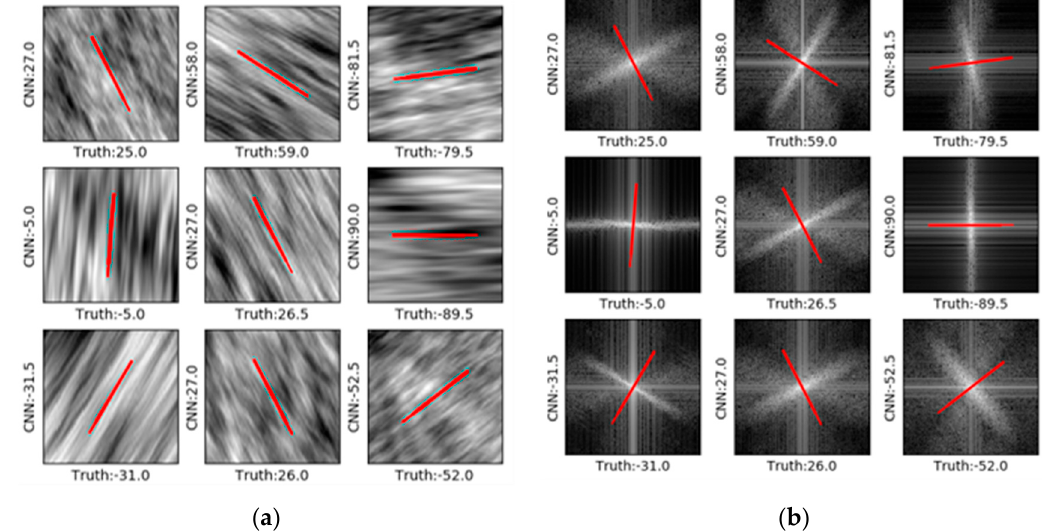
Figure 7. Application results for artificial STIs. ”Truth” labels indicate designated (ground truth) angles (in degrees), ”CNN” labels indicate estimated angles (in degrees) by CNN: ( a ) original images; ( b ) 2D Fourier transform images. Table 3. Estimation accuracy at each tolerance (correct answer rate).